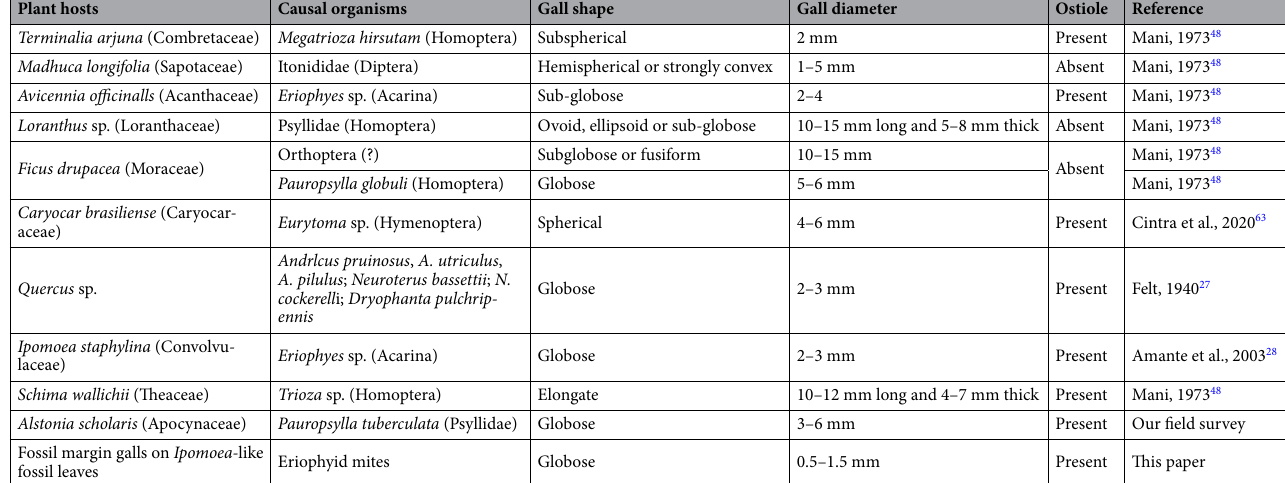
Plant hosts Causal organisms Gall shape Gall diameter Ostiole